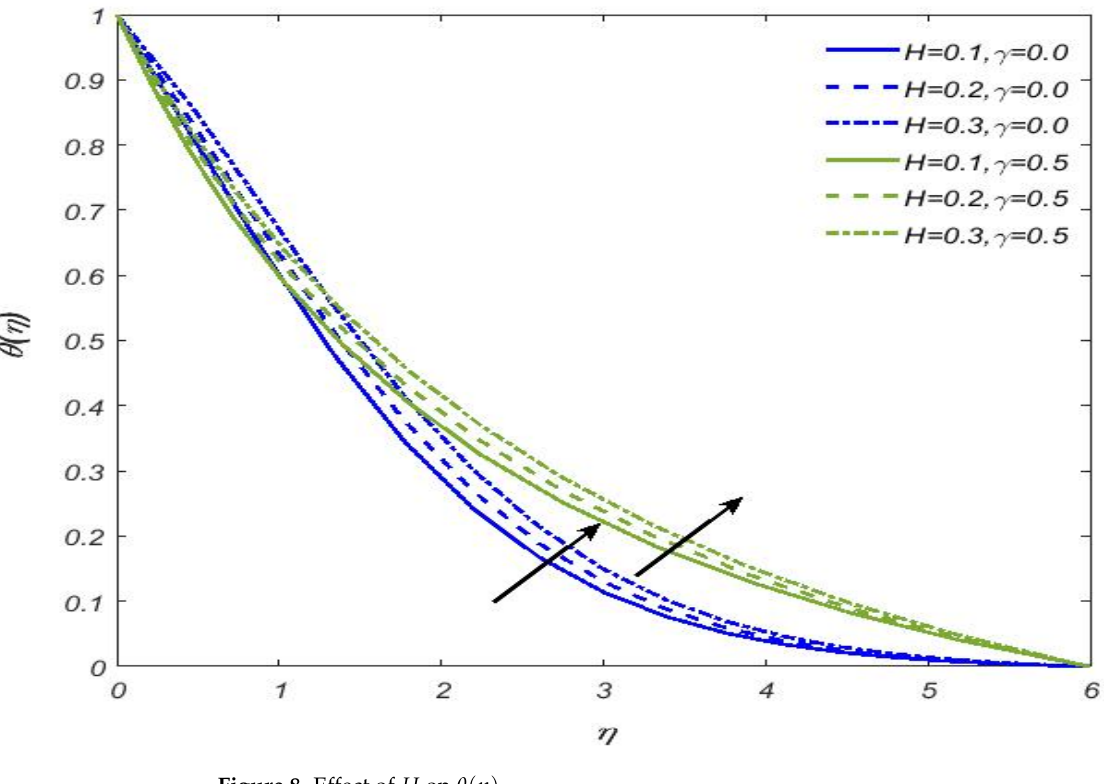
Figure 8. Effect of